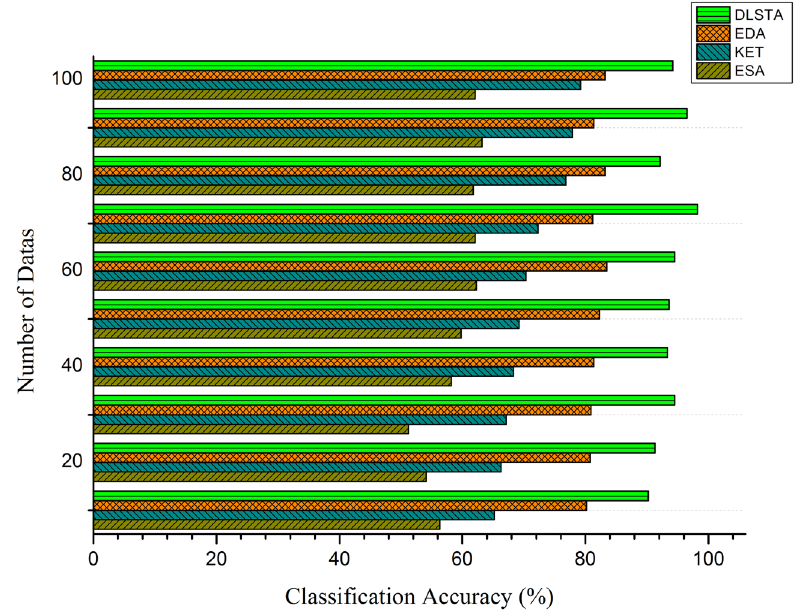
Figure 8: The classi fi cation accuracy of DLSTA.